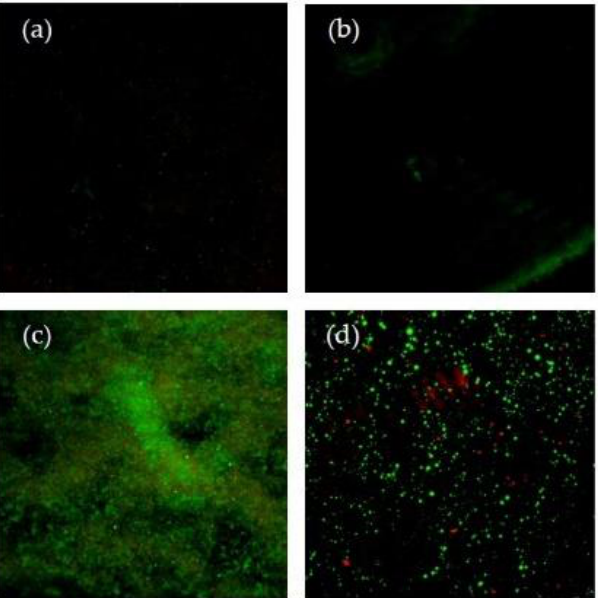
Figure 2. Confocal laser scanning microscopic images (xy-views) of the bacterial cells that adhered to dental enamel assayed by LIVE/DEAD ® BacLight™ Bacterial Viability Kits (magnification 100 ×); ( a ) deciduous enamel with S. mutans ; ( b ) permanent enamel with S. mutans ; ( c ) deciduous enamel with S. sanguinis ; ( d ) permanent enamel with S. sanguinis .